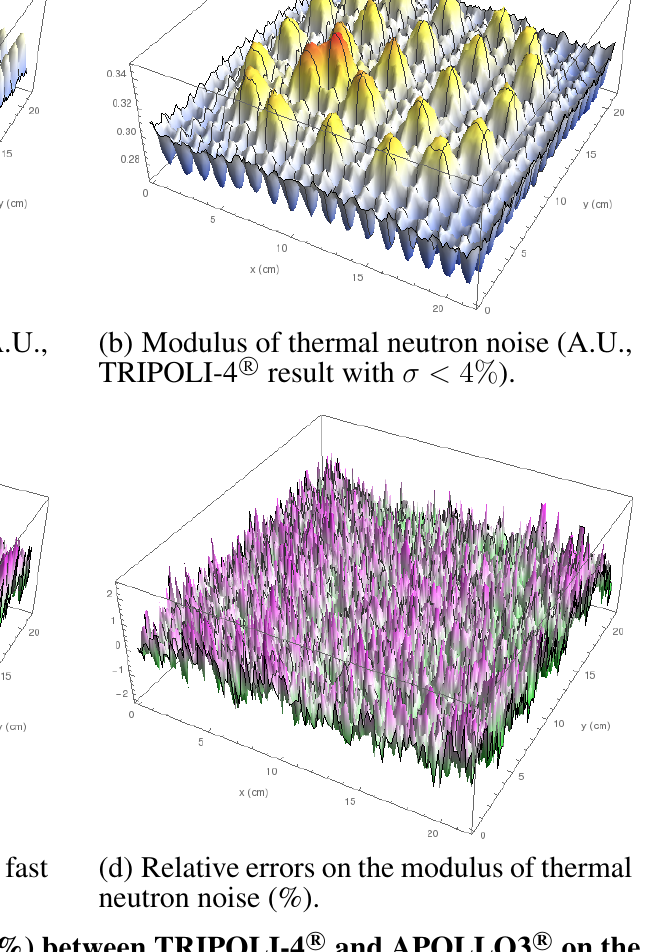
Figure 4: Results and relative errors (%) between TRIPOLI-4 R (cid:13) and APOLLO3 R (cid:13) on the modulus of δ Ψ( ω ) induced by an oscillation noise source at 1